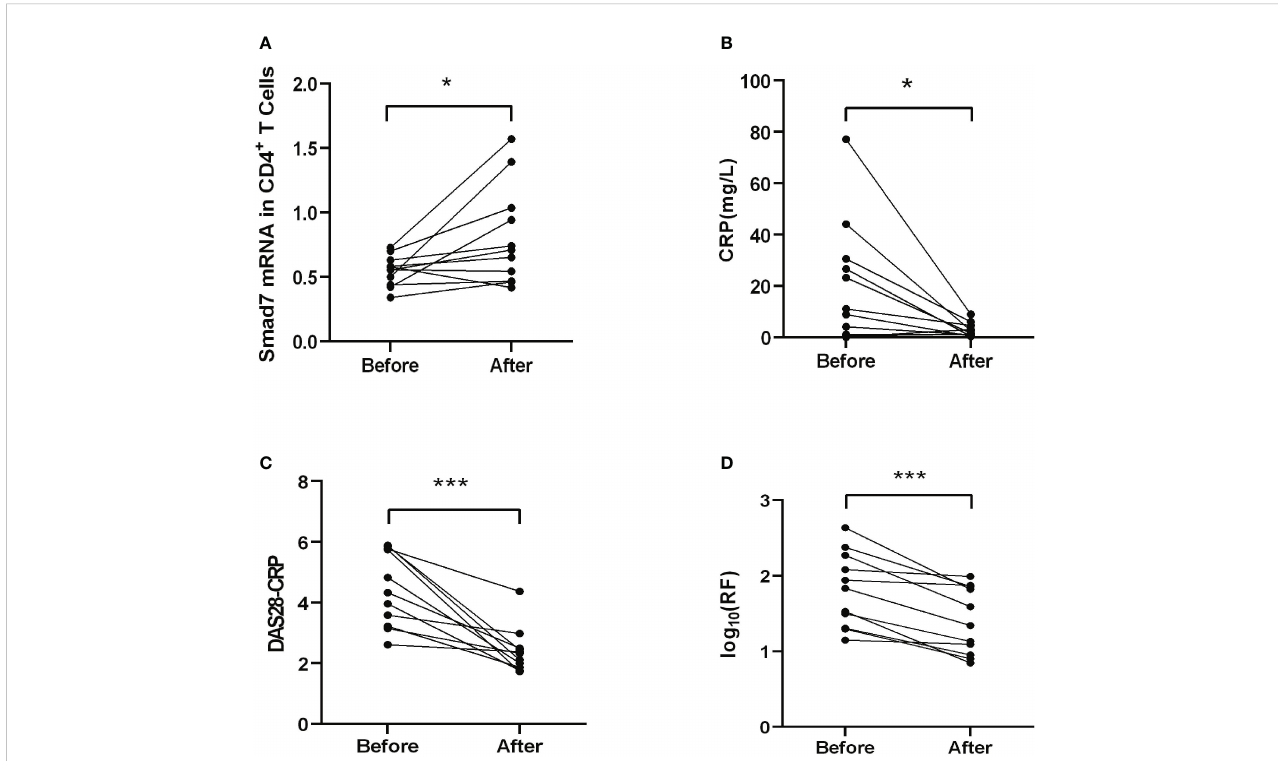
FIGURE 3 Therapeutic effect on Smad7 mRNA expression of the peripheral CD4 + T cells and the clinical indexes in RA patients. (A) The mRNA level of Smad7 in peripheral CD4 + T cells of RA patients before and after treatment. (B) The serum levels of CRP before and after treatment. (C) The DAS28-CRP score before and after treatment. (D) The serum levels of RF before and after treatment. *P < 0.05, ***P < 0.001 .